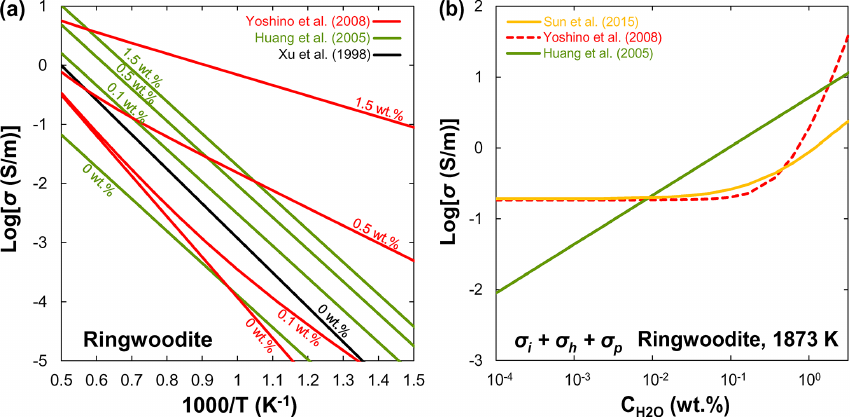
Figure 7. Compilation of electrical conductivity data of ringwoodite aggregates as a function of water content. (a) Log conductivity versus reciprocal temperature. (b) Log conductivity versus water content at 1873K. The number labels indicate water content in weight